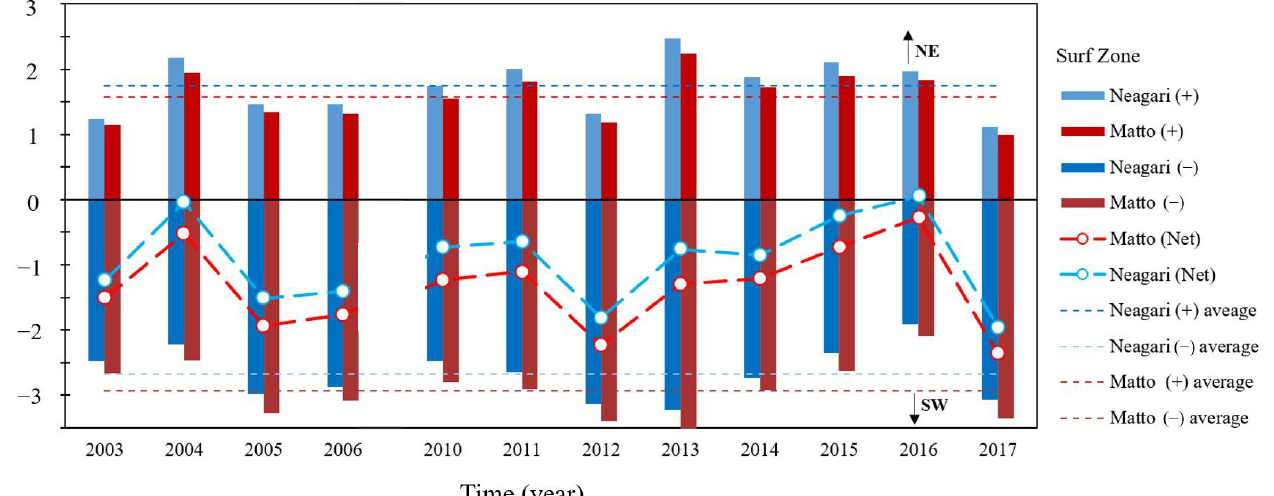
Figure 8. Cumulative and net sediment transport in the offshore zone, both cumulative and net value in each interval (calculated approximately once a year based on the date of bathymetric sur- veys conducted annually). Since sediment moves in both directions, the positive and negative terms are displayed in addition to the value’s sum. In the offshore zone, the northeastward cumulative sediment transport was more dominant over the southwestward cumulative sediment transport. Therefore, the net longshore sediment transport was approximately equal to the cumulative sediment transport in the northeast direction. The 𝑄 𝑎𝑅𝑂 was estimated to be considerably larger than the 𝑄 𝑎𝐿𝑂 . The difference in the longshore sediment transport between the two boundaries was due to the spatial variation in the sediment grain size. The sediment on the coast of the right side of the Tedori River mouth was comprised mainly of fine-grained sand that was well-sorted and homogenized, whereas the sediment on the coast of the left side of the river portrayed a wider range of grain sizes and a mixture of medium- and coarse- grained sand (Figure 9). Thus, it is considered that the sediment suspension and transport at the southwestern boundary were less frequent than those at the northeast boundary.